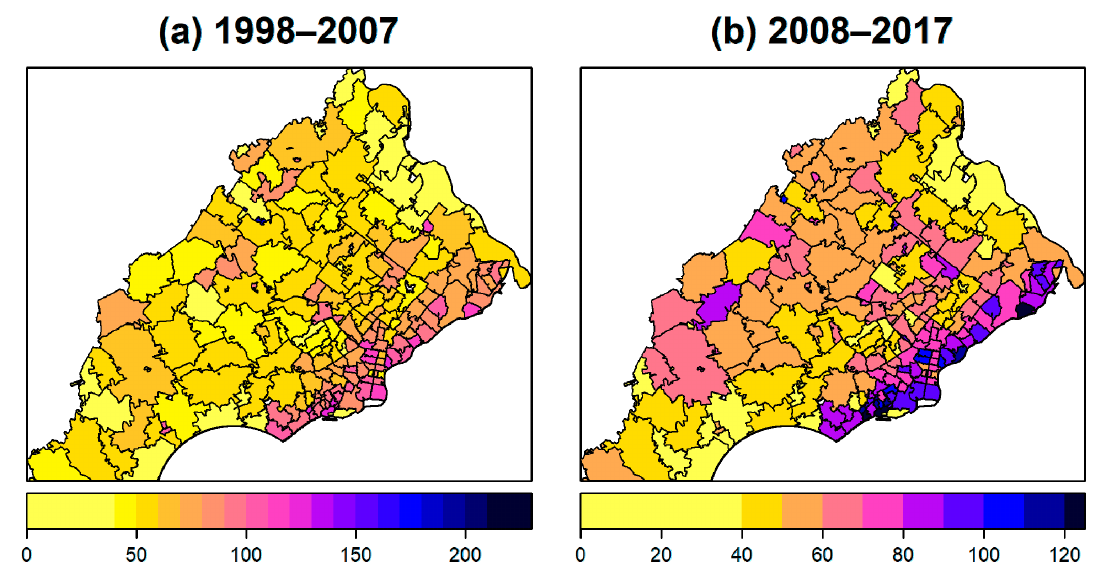
Figure 3. Maps of ten-year age-adjusted incidence rates per 100,000 for ( a ) 1998 to 2007 period, and ( b ) 2008 to 2017 period.